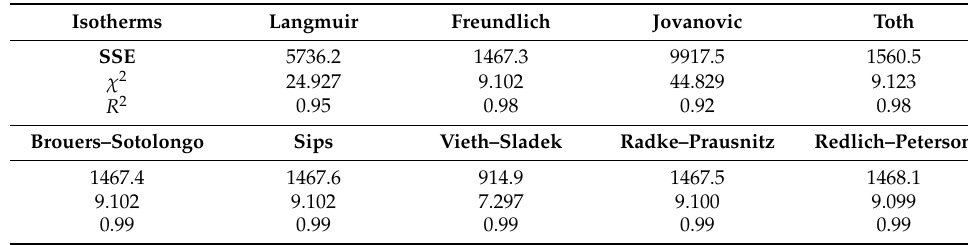
Table 5. Statistical parameters for adsorption isotherm model fitting.